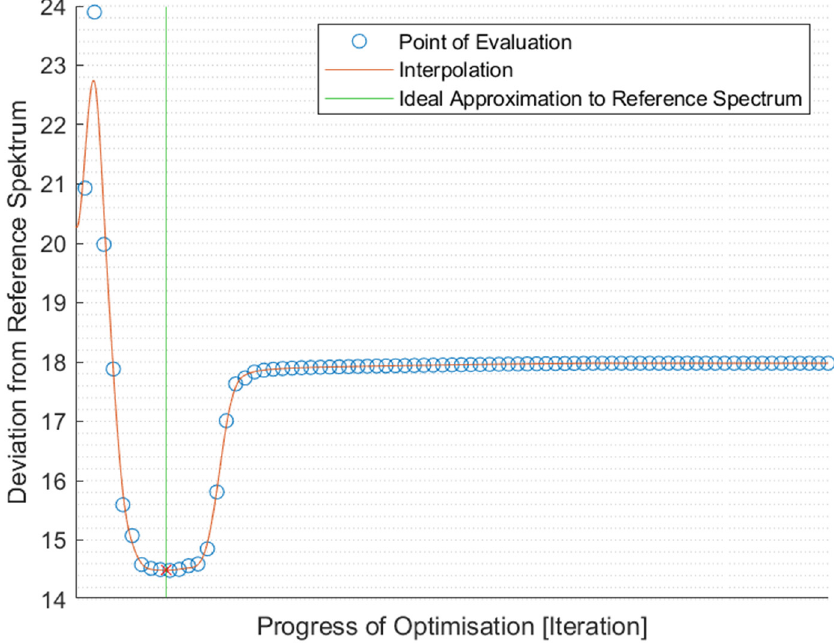
Figure 9. Progress of the optimisation over the deviation of the resulting spectrum from the reference